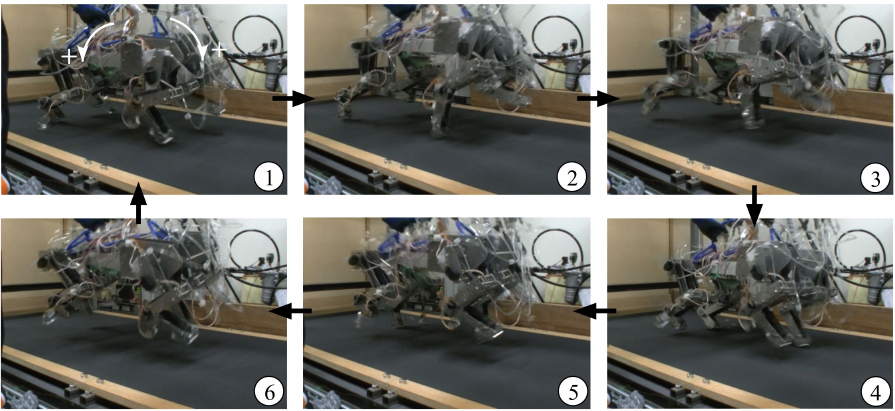
Figure 9. Snapshots of our quadruped robot running at a pace. 1 (cid:13) – 6 (cid:13) indicate the running